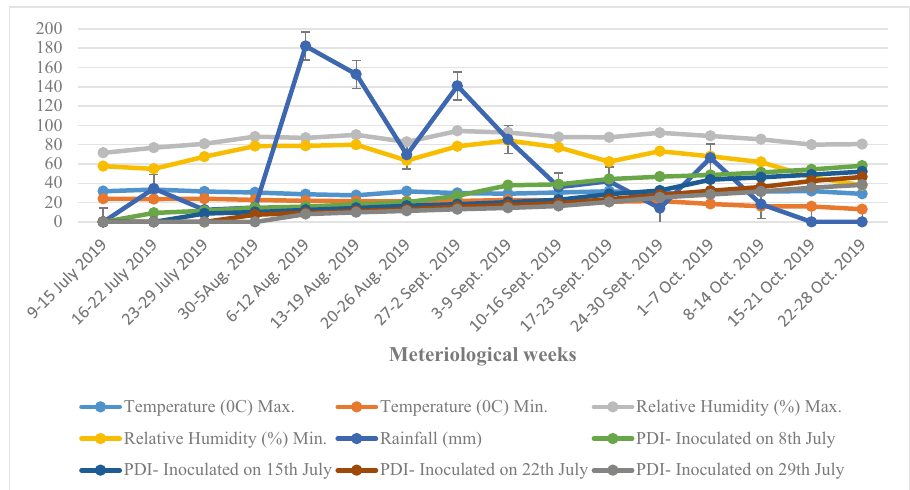
Figure 2. Progression of Alternaria leaf spot on soybean in relation to weather parameters in different dates of sowing under epiphytotic conditions during Kharif 2019.